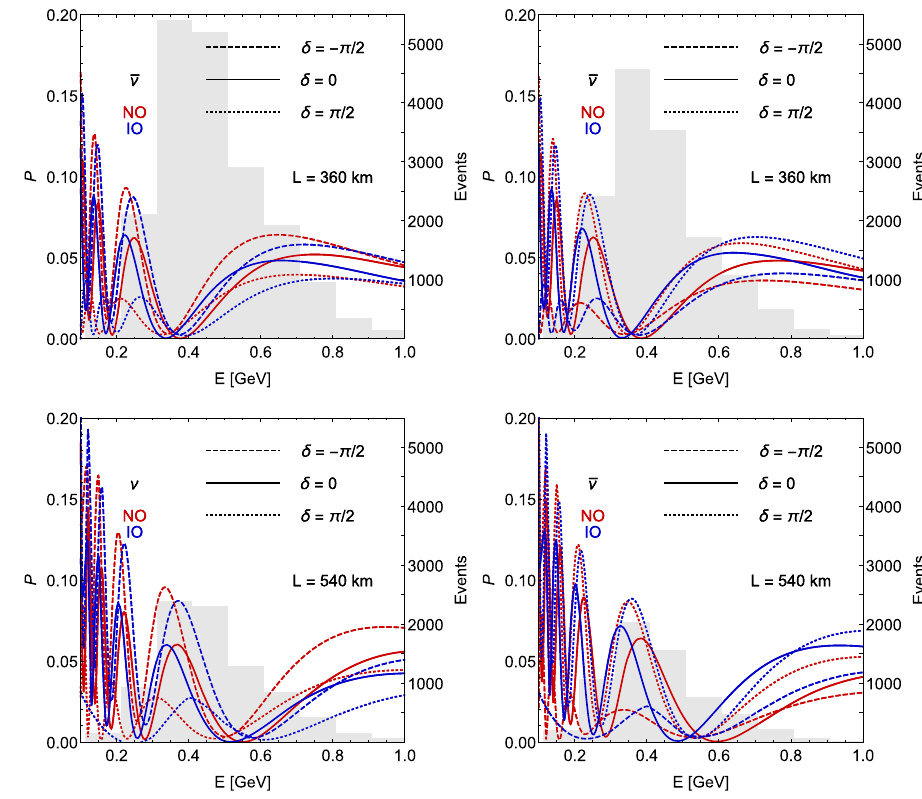
Fig. 1 Oscillation probabilities for the Zinkgruvan (upper panels) and Garpenberg (lower panels) baselines as a function of the energy for neutrinos (left panels) and antineutrinos (right panels). The red (blue) lines are for normal (inverted) ordering and three different values of δ = − π/ 2, 0 and π/ 2 are represented by the dashed, solid and dotted lines respectively. The grey histograms show the number of events that would be obtained in each energy bin for a 2/8 time splitting between neutrino/antineutrino mode if the oscillation probability was 1. Thus, they serve as a guide of what energies of the oscillation probability would be well-sampled by the ESS ν